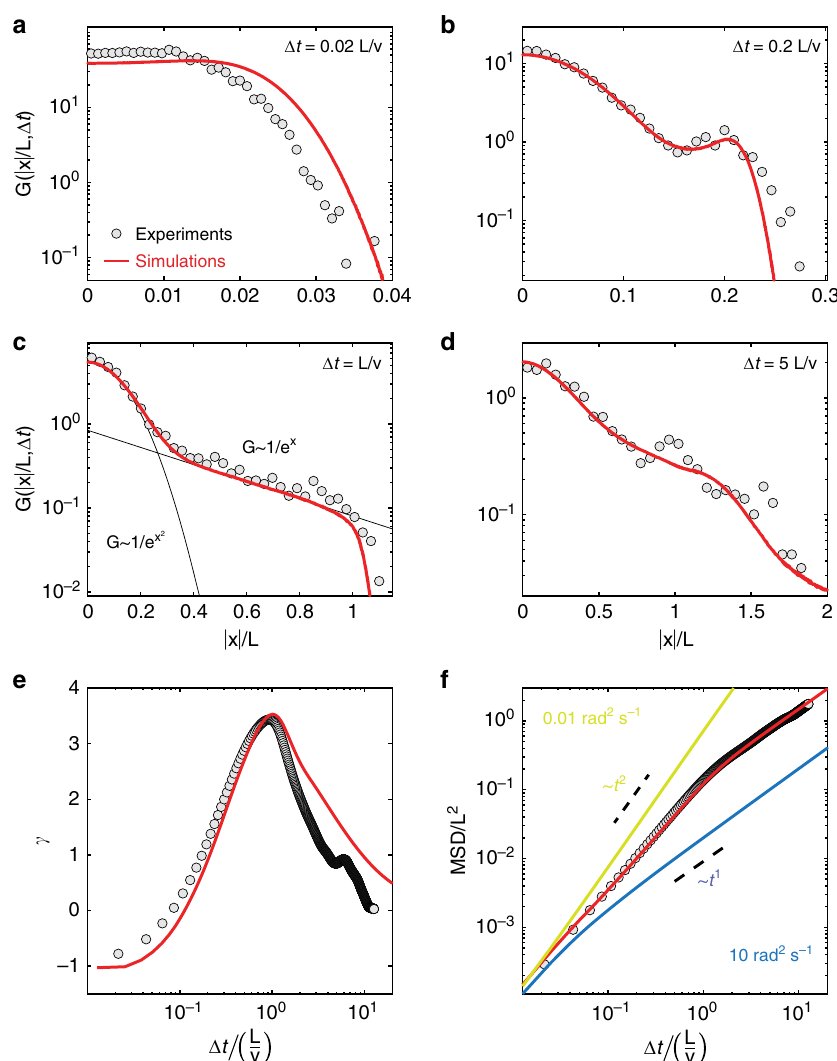
Fig. 3 Non-Gaussian statistics and exponential tails due to D R varying according to a checkerboard pattern. Experimental and simulated data are plotted as circles and red lines, respectively. a – d Probability distributions of rescaled one-dimensional displacements G ( ∣ x ∣ / L , Δ t ), for Δ t ( L / v ) − 1 = 0.02 ( a ), 0.2 ( b ), 1 ( c ), and 5 ( d ). One-dimensional displacements in x and y are cumulated to increase statistics. The black lines in the third panel ( Δ t ( L / v ) − 1 = 1) are a Gaussian and an exponential fi t to G ( ∣ x ∣ / L , Δ t ) in the range ∣ x ∣ / L ≃ 0 − 0.2 and ≃ 0.4 − 1, respectively. e Excess kurtosis γ of G ( x / L , Δ t ) as a function of Δ t ( L / v ) − 1 . f Rescaled mean squared displacement MSD/ L 2 as a function of Δ t ( L / v ) − 1 . The yellow and blue straight lines are the theoretical MSDs of ABPs = 10 rad 2 s − 1 , D L ¼ 0 : 01 rad 2 s − 1 , and τ = 0.2 with constant D R , equal to D L and D H , respectively ( v = 4 μ m s − 1 , L = 32 μ m, D H R R R R